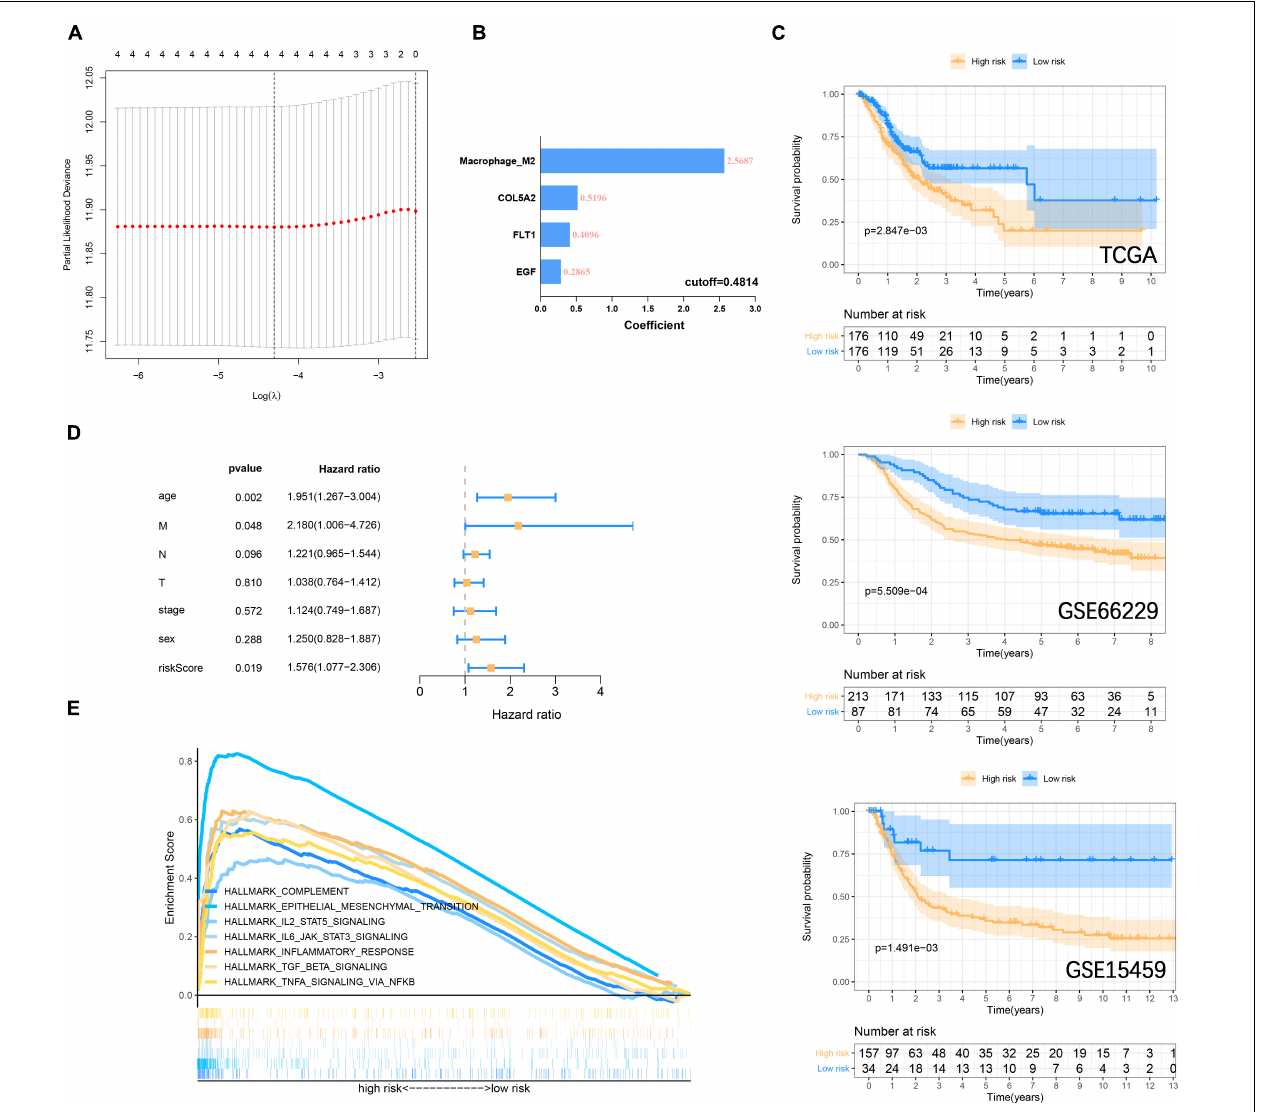
FIGURE 7 | Construction and verification of risk prognostic signature (A) LASSO Cox regression model shows that four risk factors are included in the risk signature. (B) Four risk factor coefficients and cut-off values. (C) Kaplan-Meier curve is drawn to evaluate the overall survival of GC patients in low-high risk groups. (D) Riskscore and clinicopathological characteristics Multivariate cox regression analysis in the TCGA cohort. (E) GSEA shows that immune-related signaling pathways are significantly enriched in the high-risk